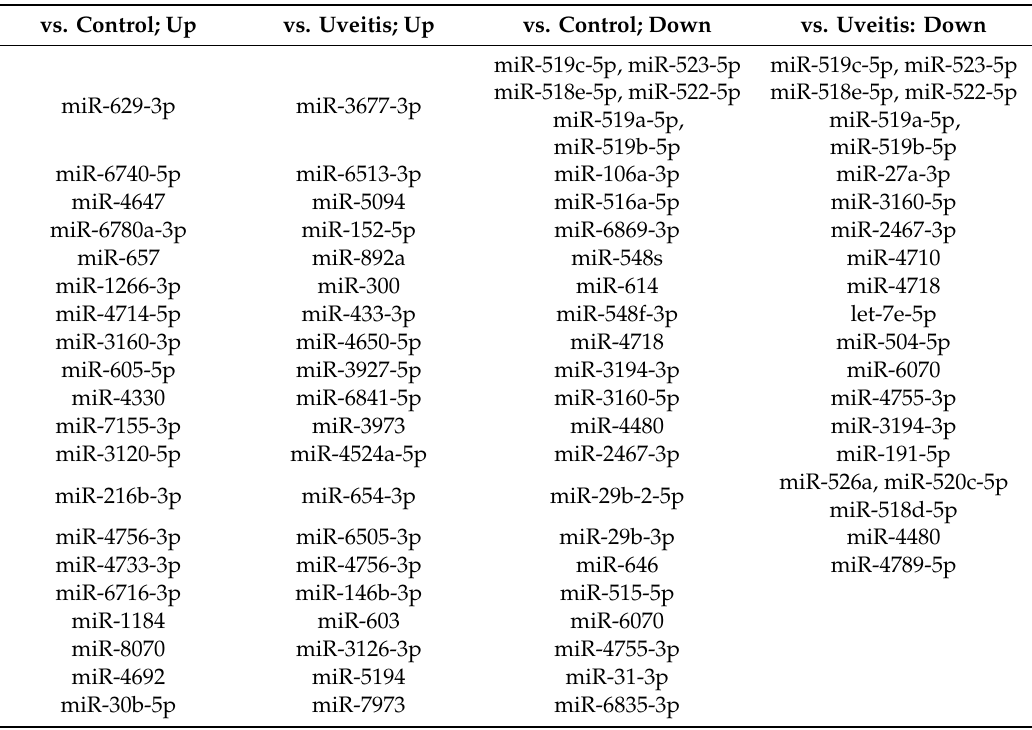
Table 2. Vitreous miRNAs modulated in vitreoretinal lymphoma versus control and uveitis with vitreous opacity, showing the top 20 in descending order of p